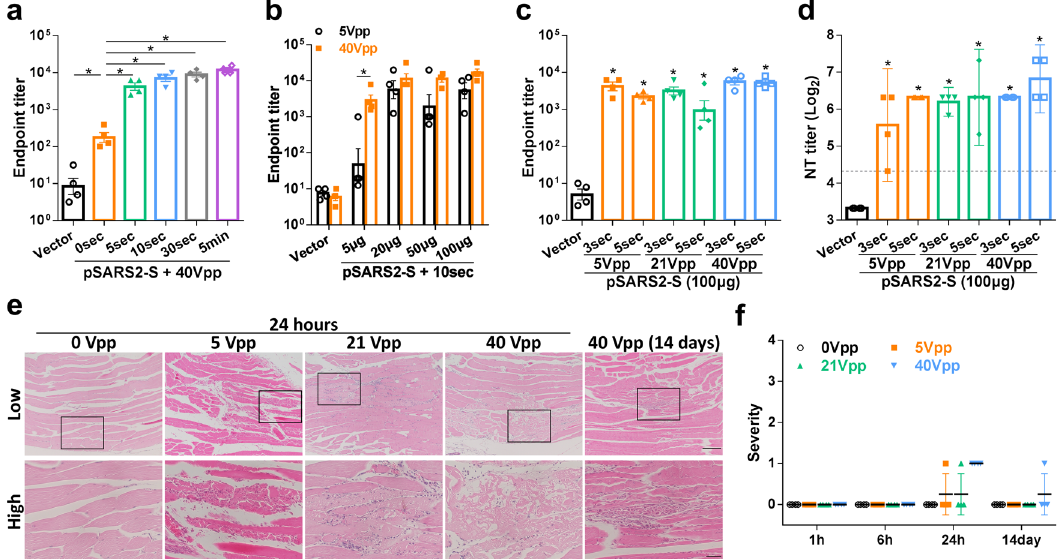
Fig. 1 Optimization of electrostimulation conditions using electroacupuncture machine. BALB/c mice ( n = 4 per group) were intramuscularly immunized twice at a 3-week interval with vector or pSARS2-S DNA, followed by electrostimulation by an electroacupuncture machine under different peak-to-peak voltages (Vpp), total stimulation times, or amounts of DNA. Serum samples were collected at week 6 after the fi rst immunization. a – c IgG antibodies against spike protein were assessed by ELISA. d Vaccine ‐ induced neutralizing activity against wild-type SARS-CoV-2 was evaluated by neutralization assay. The dashed line indicates the initial fold dilution of serum samples. e , f BALB/c mice were electrostimulated with 0, 5, 21, and 40 Vpp for 5 s. At the indicated timepoints after electrostimulation, muscle tissues at the injection site (gastrocnemius muscle) were collected and examined by hematoxylin and eosin staining. e Representative images of in fl ammation in the muscle tissue. Enlarged views of the area in the black box are shown at the bottom. Scale bar for low-magni fi cation: 200 μ m, for high-magni fi cation: 50 μ m. f The in fl ammatory severity score was evaluated based on the percentage of the in fl ammatory area. Antibody titers and severity scores are presented as the mean ± SEM, and neutralization titers are expressed as the geometric mean with a 95% con fi dence interval. * p < 0.05 by the Mann – Whitney